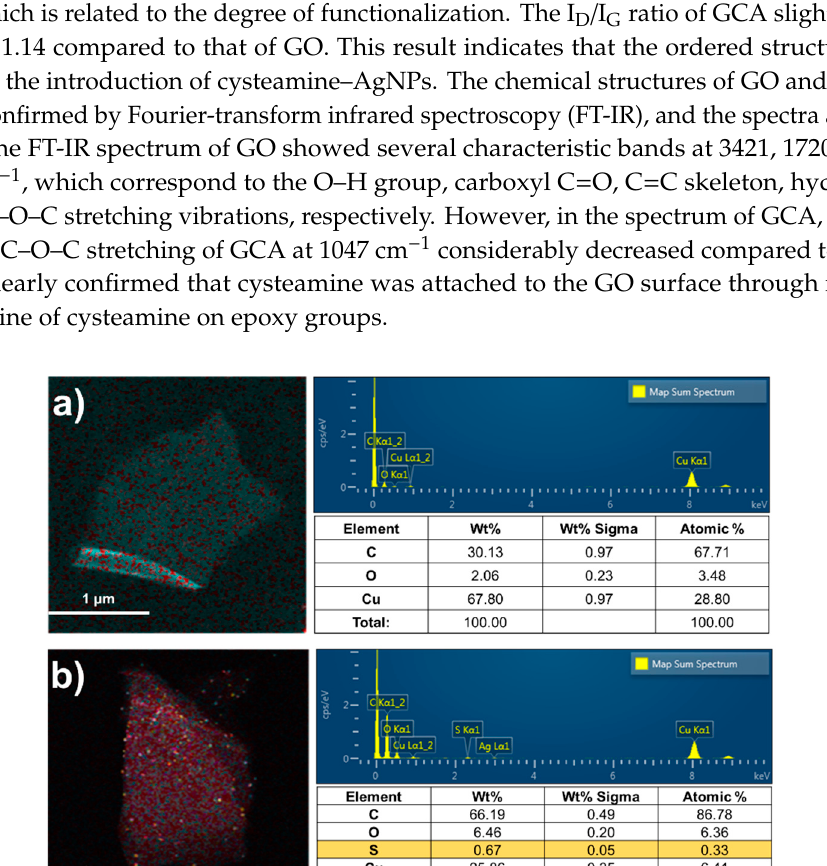
Figure 2. GCA-AgNW TEM image. ( a ) GCA 1:1 -AgNW not annealed, ( b ) annealed GCA 1:1 -AgNW, ( c ) annealed GCA 2:1 -AgNW. Surface morphology was investigated by AFM, and Figure 3 shows images and the corresponding root mean square roughness (RMS) values for (a) AgNWs before annealing, (b) annealed AgNWs, (c) GCA 1:1 –AgNW before annealing, (d) annealed GCA 1:1 –AgNW, (e) GCA 2:1 – AgNW before annealing, and (f) annealed GCA 2:1 –AgNW. RMS was measured in the area of 2.5 × 2.5 μ m 2 and calculated by averaging the results of five or more measurements of the sample. Surface morphology explains that when AgNWs are covered with GCA, the RMS value is slightly increased. However, the annealing process clearly reduced the RMS roughness value.